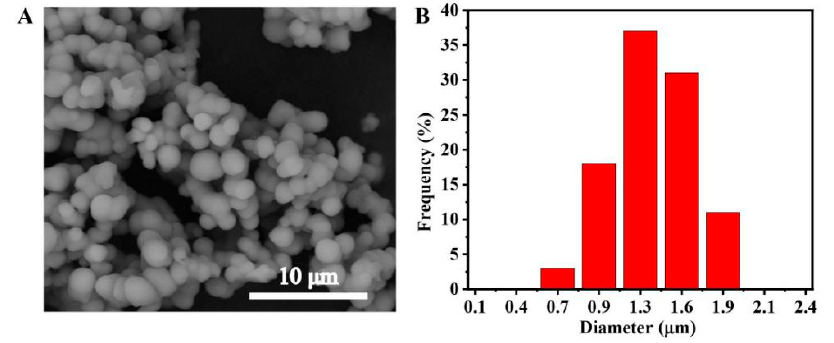
Figure 3. ( A ) SEM image of poly([V 2 C 4 (mim) 2 ]Br 2 ). ( B ) Size distribution diagram of poly([V 2 C 4 (mim) 2 ]Br 2 ).